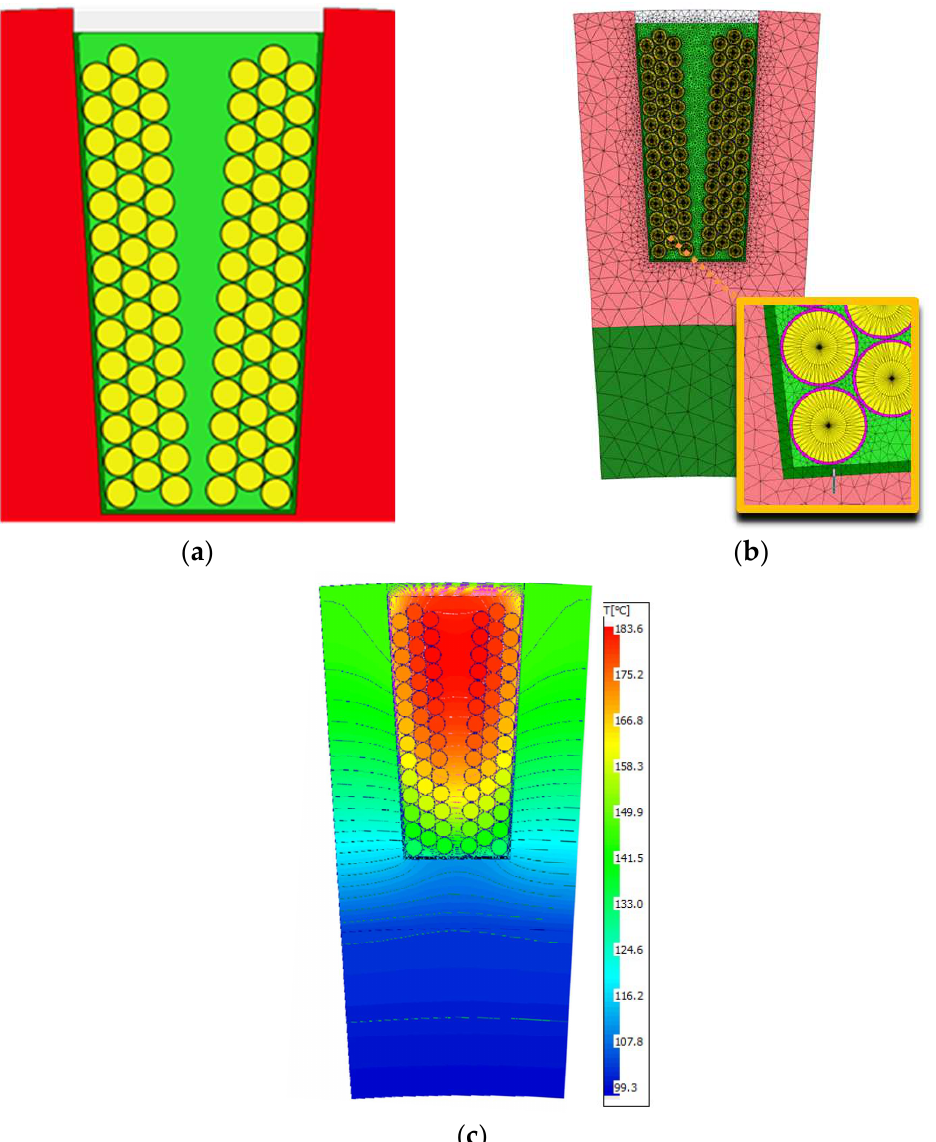
Figure 9. Longitudinal section of the circuit model of the motor with the housing: ( a ) through the stator slot; ( b ) FEM model; ( c ) simulation result ( T m = 902 Nm, n = 400 rpm) .